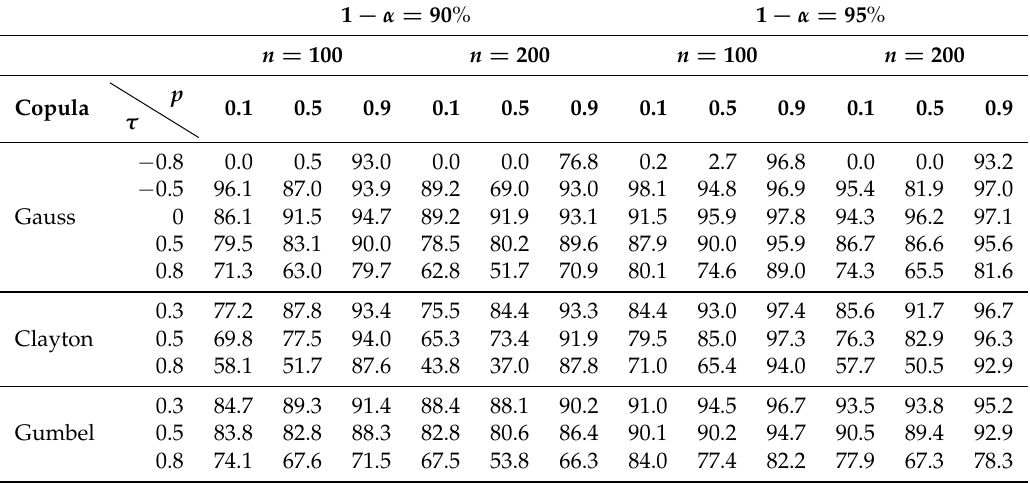
Table 2. Simulation results for the extended Chen et al. [15] approach. The overall results are